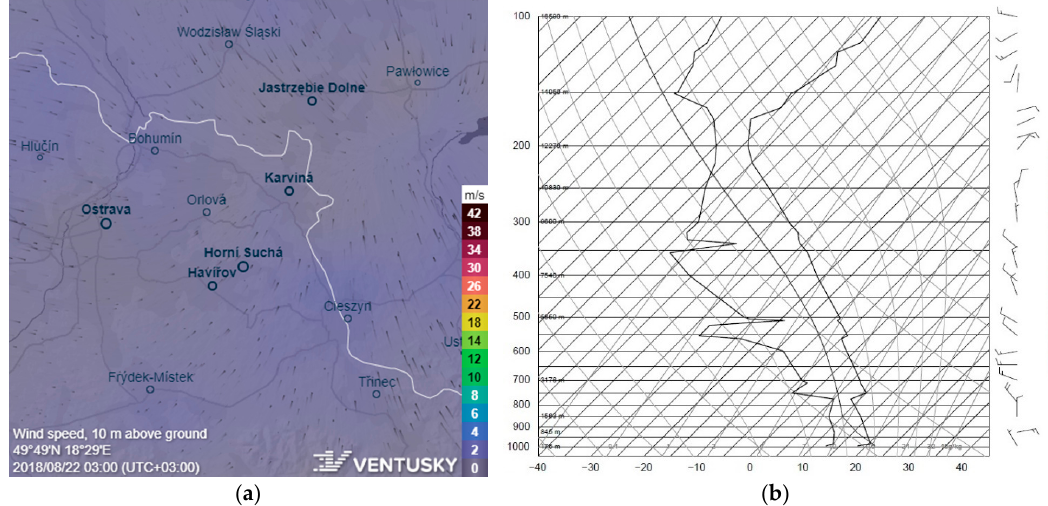
Figure 7. The modelled wind fields ( a ) and the Skew-T diagram at the Prost ě jov sounding station ( b ) for August 2018 peak concentrations [48,49].